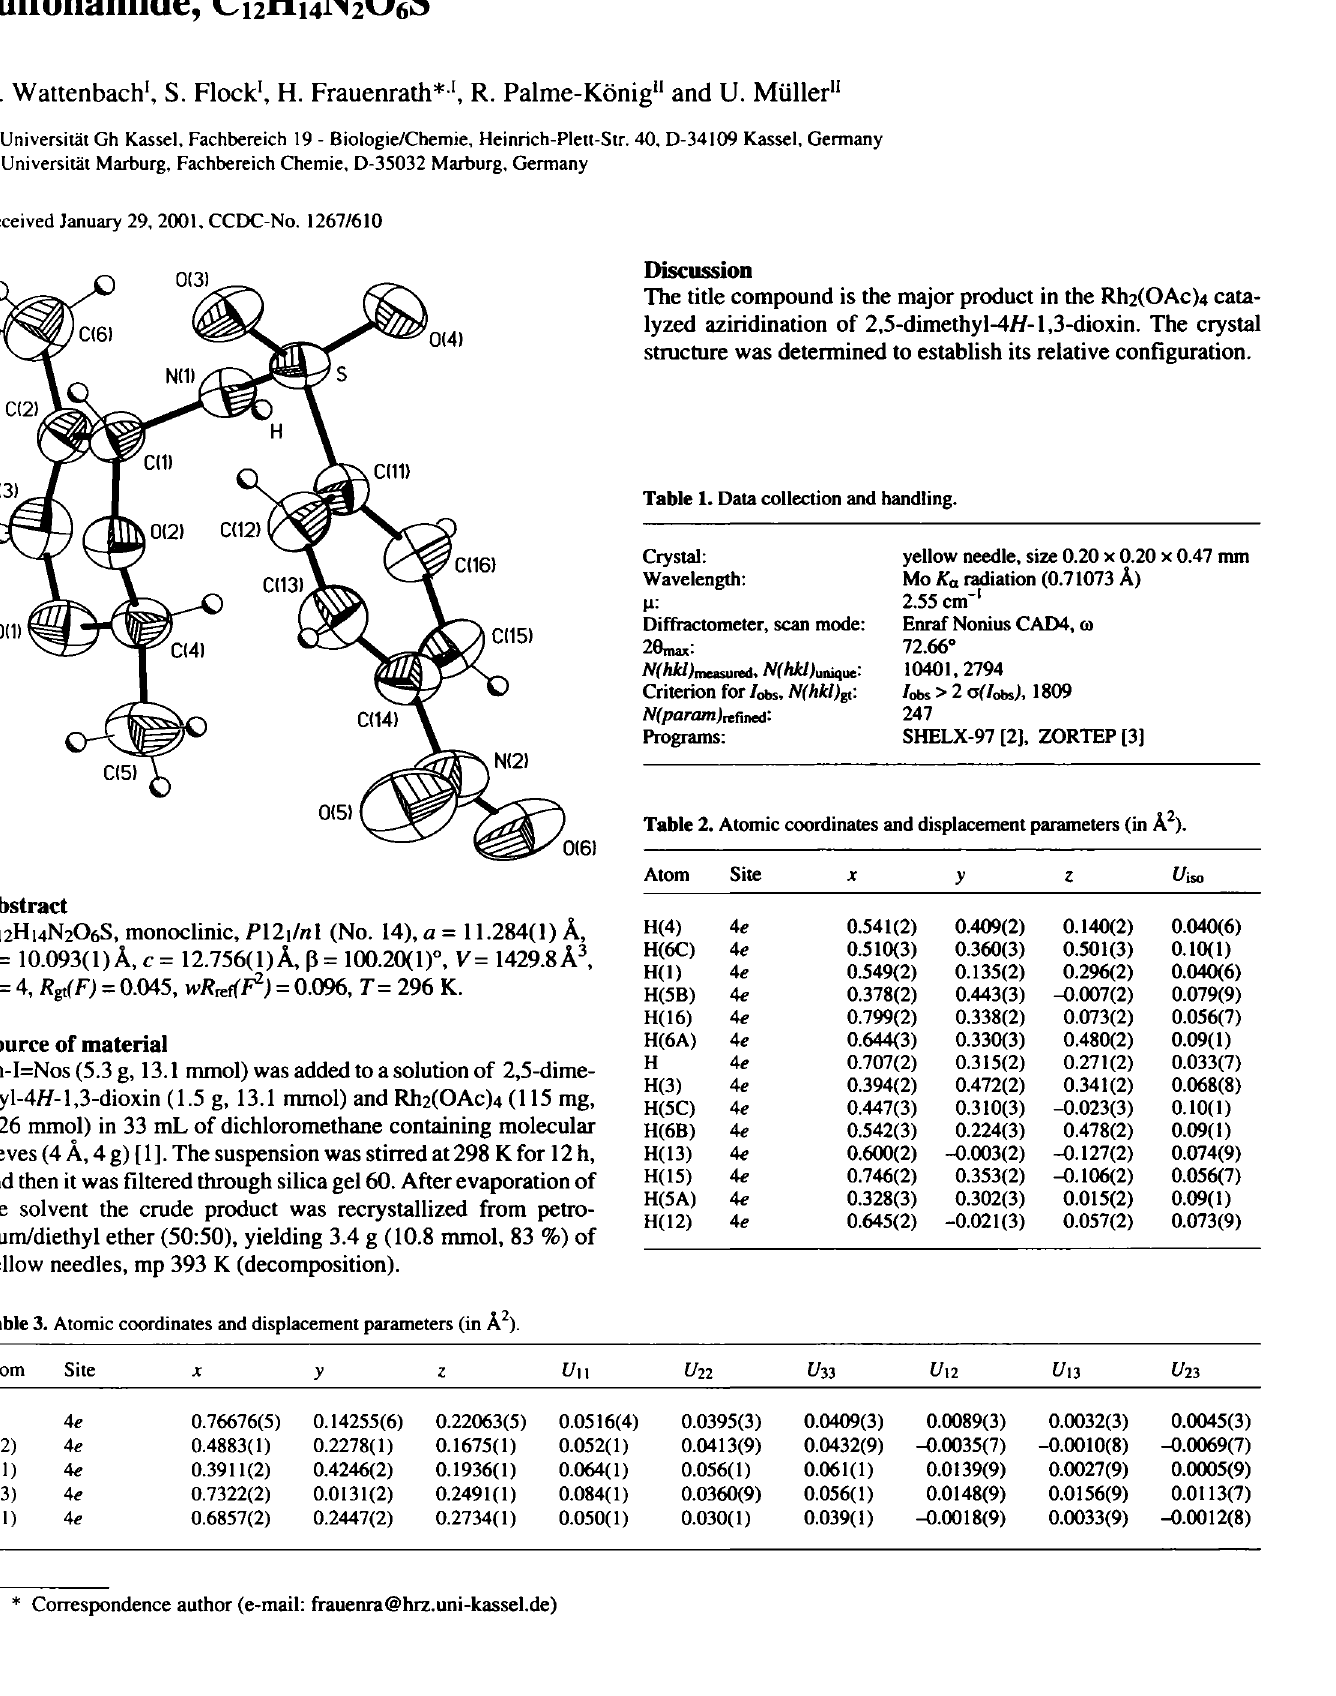
Table 1. Data collection and handling.